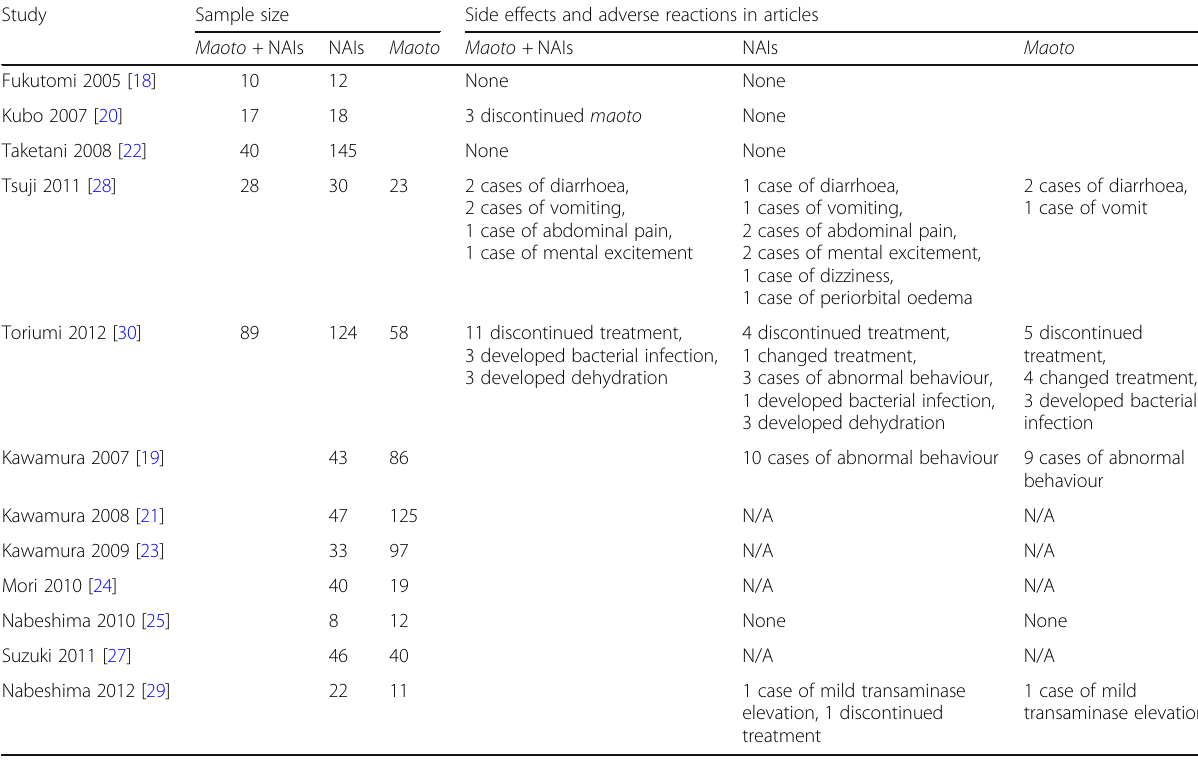
Table 2 Side effects and adverse reactions Study Sample